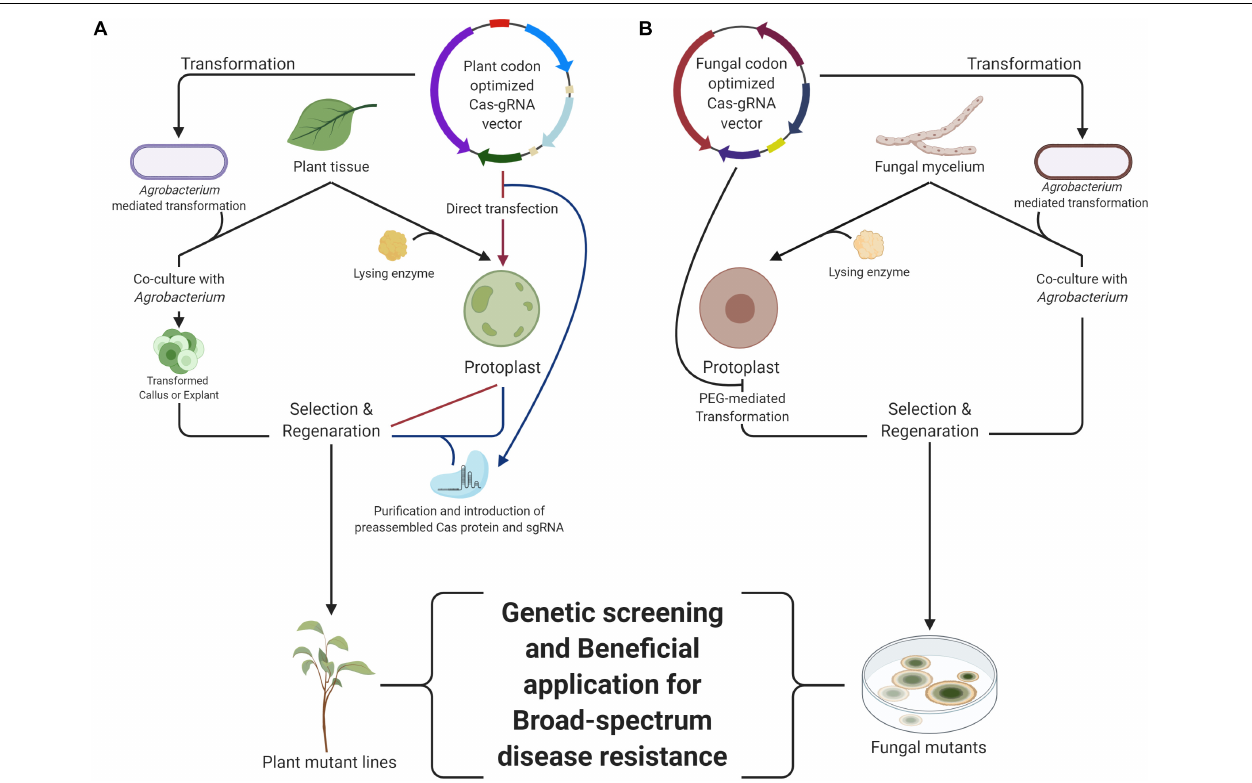
FIGURE 1 | The workflow of CRISPR/Cas system in the plant (A) and fungi (B) . The Agrobacterium -mediated transformation is the common method for genomic modification in plants, including the CRISPR/Cas system delivery. The CRISPR/Cas system is being inserted into the plant genome. The ribonucleoprotein (RNP) delivery into plant protoplast generates no trace except targeted modification in desired loci in the genome. They can be delivered by direct transfection or introduction of a preassembled CRISPR/Cas system. The Polyethylene glycol, PEG-mediated transformation is the common method for genomic modification in fungi, which resembles direct transfection of binary vector to plant protoplast. The Agrobacterium -mediated transformation is also optional in the fungal genome modification. With these transformation methods, generation of broad-spectrum resistance can be performed by using each or both mutants. This figure was created with